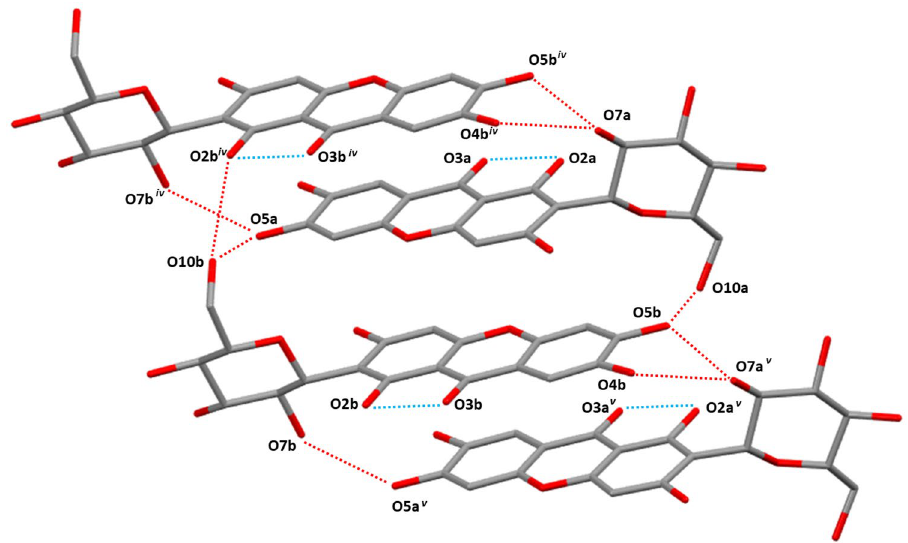
Fig. 4 Main hydrogen bonds of O–H ⋯ O along b-axis in form II (Turquoise dashed lines showed intramolecular hydrogen bonds, red dashed lines indicated intermolecular hydrogen